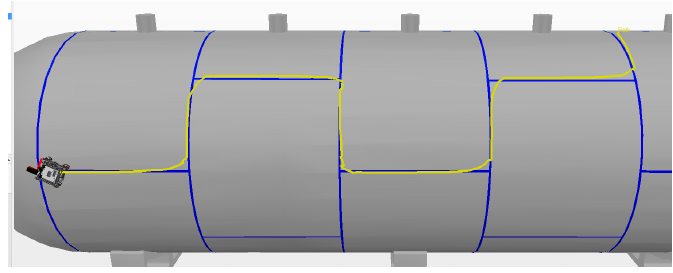
Figure 23. Experiment carried out in Supervisory Mode.